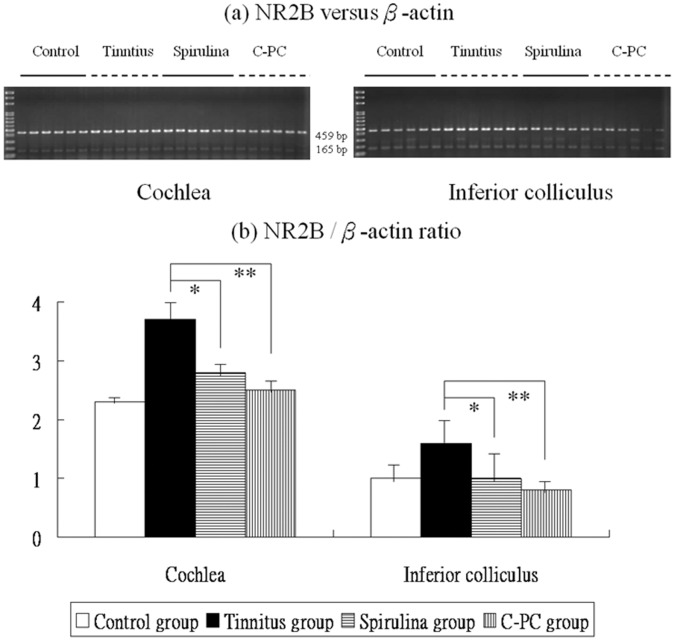
The levels of NR2B mRNA expression in the four groups (a,b).There are significant differences in these levels among the four groups. The NR2B mRNA expression were significantly higher in the salicylate group than the control group. Compared to the tinnitus group, the Spirulina group (*) or C-PC group (**) exhibits significantly reduced NR2B mRNA levels in the cochlea and IC.